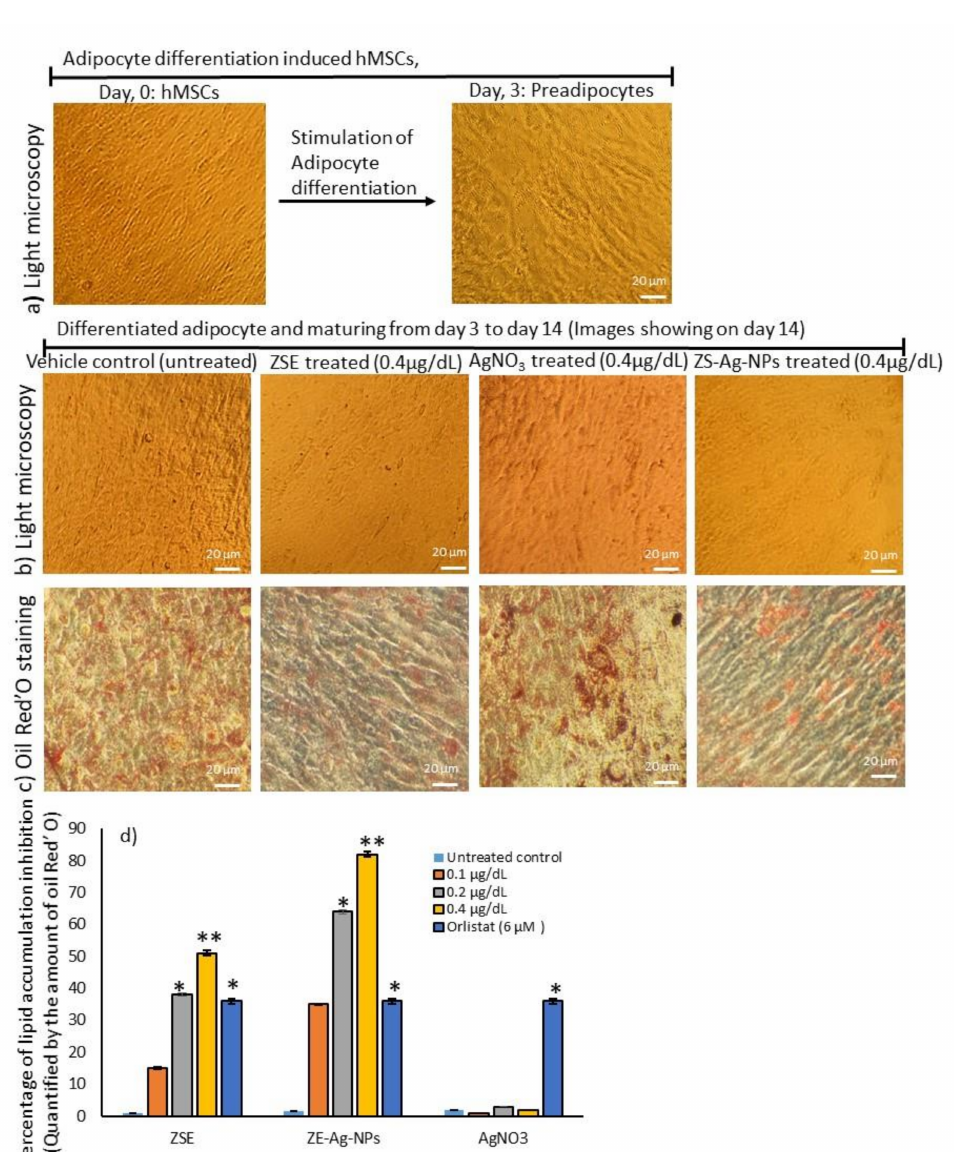
Figure 3. Images of adipocyte differentiation ( a ) in 3 days. Images of light microscopy ( b ), lipid accumulation by oil red’O staining ( c ), and the lipid inhibition percentage as quantified by oil red’O staining ( d ) of the effect of Ziziphus spina (jujube) root methanol extract (ZSE) and Ziziphus spina (Jujube) root loaded silver nanoparticle (ZS-Ag-NPs) on the adipocyte maturation after 14 days. Each value is a mean ± SD ( n = 6). * significant at p ≤ 0.05 and ** highly significant at p ≤ 0.001, by comparison with the vehicle